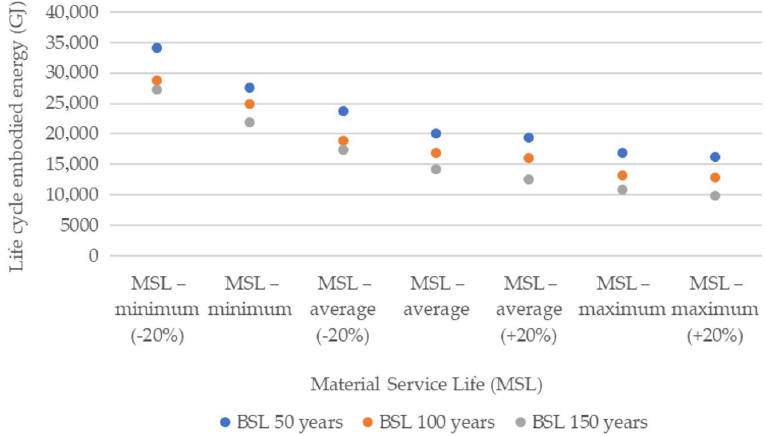
Figure 13. Life cycle embodied energy impact of BSL and MSL variations (150-year assessment period).